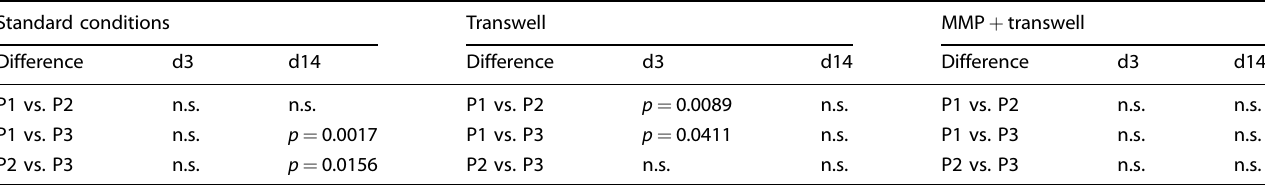
Table 2. Statistical differences calculated based on the quanti fi ed recellularization ef fi ciency (cell density) of different scaffold types (protocol 1, P1; protocol 2, P2; protocol 3, P3) compared with the same recellularization strategy and time point (d, days in vitro; MED, median; n.s., not signi fi cant). Standard